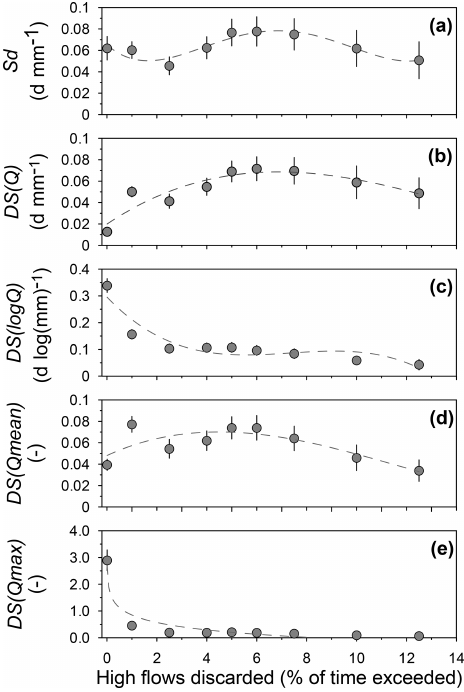
Figure 2. Behaviour of the different discharge sensitivity metrics in the Can Vila catchment when measurements corresponding to the highest flows are sequentially discarded. Percentage of time exceeded refers to the flow duration curve. Vertical bars represent standard errors, and dashed lines are ancillary polynomial